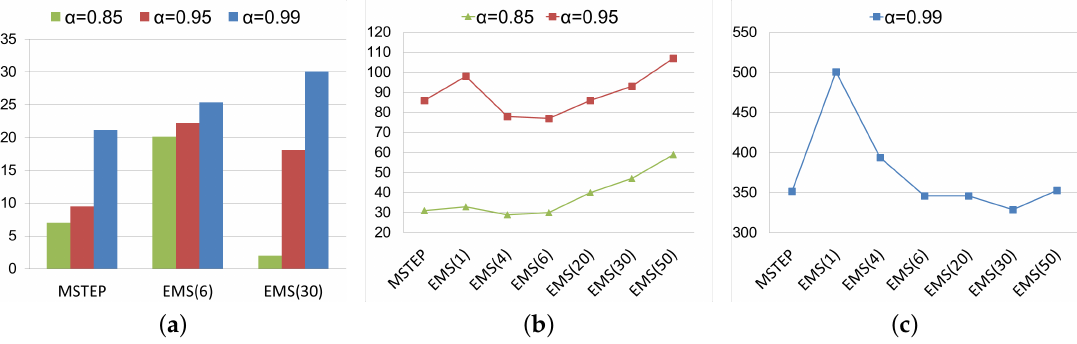
Figure 5. Comparison of convergence rates of the EMS methods with respect to the Power method, it-2004, SM p = 4 ( 1 × 4 ) , q = 2, (cid:101) = 10 − 6 . ( a ) Number of iterations. ( b ) Time reduction (%). ( c ) Time reduction